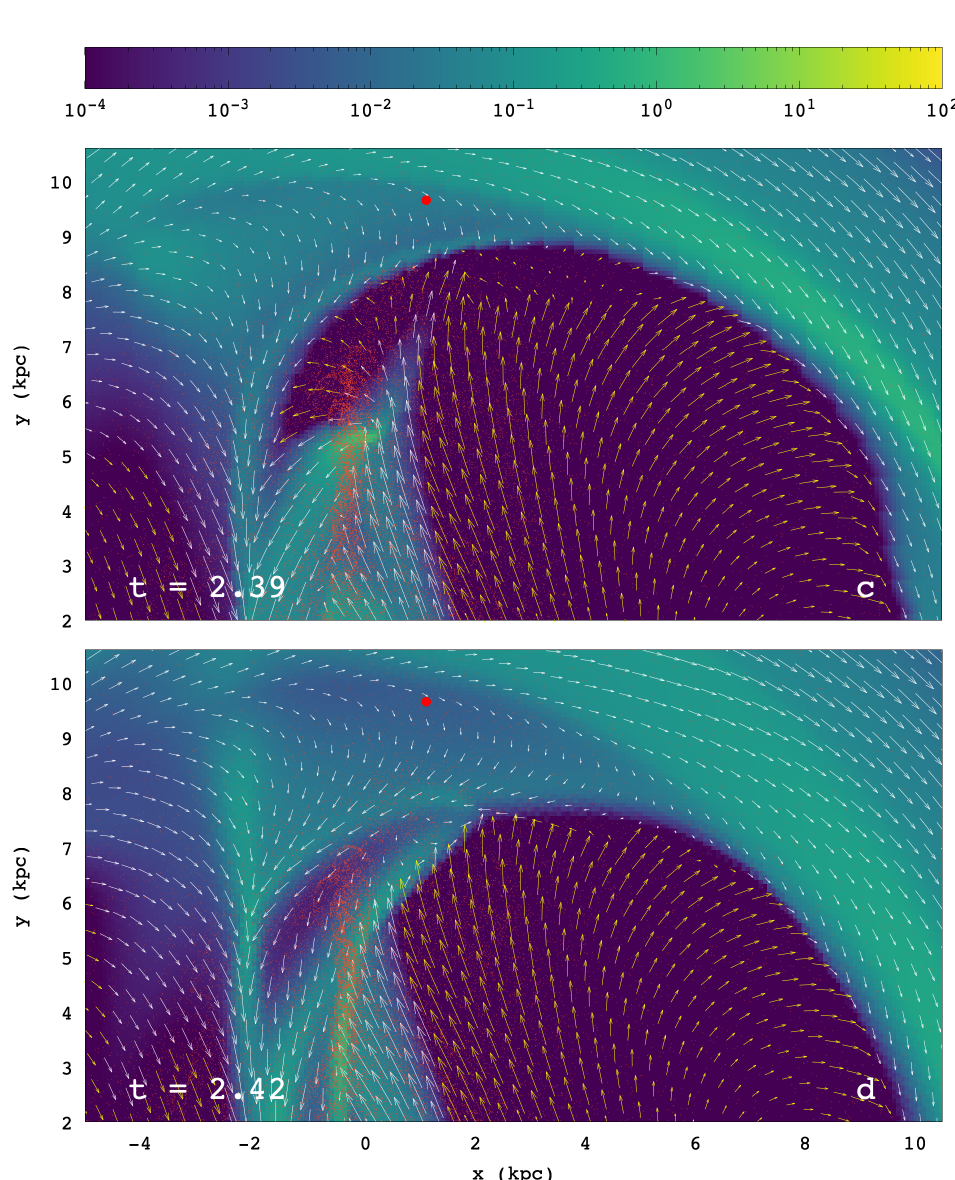
Figure 14. ( a – d ): Characteristic evolution of the flow at the end and beyond the x1-bar region within a ∆ t = 0.11 period, during which the extension towards the Γ -like feature breaks and forms again. Times are given at the lower left corner of the panels. The flow in the upper branch of the Γ feature splits, pointing to two opposite directions at the points indicated with heavy yellow arrows in ( a , b ). The long white arrow in ( a ) indicates the point “A”, where the tail of the L feature join the dust-lane shock in the bar region. Red dots mark the location of L 1